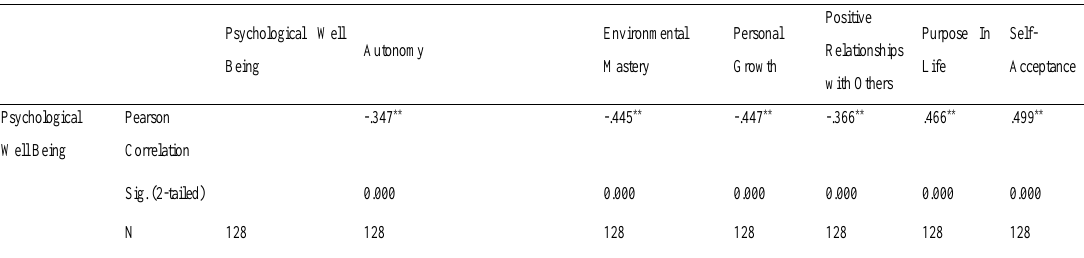
Table 4: Correlation